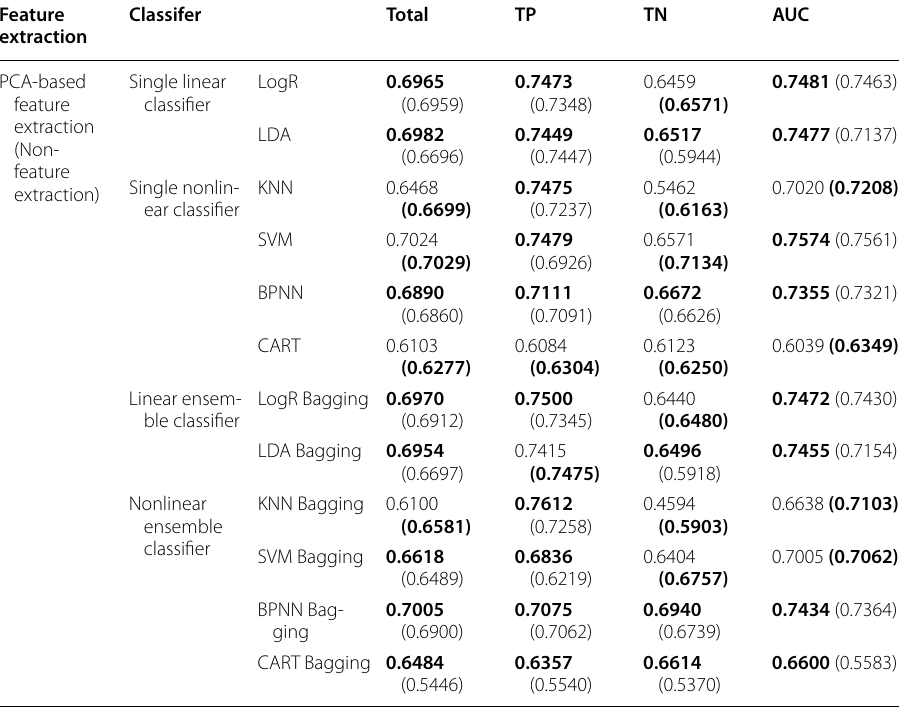
Table 2 Results of different classifiers with/without PCA in China Unionpay dataset when 100 < feature dimensions < sample